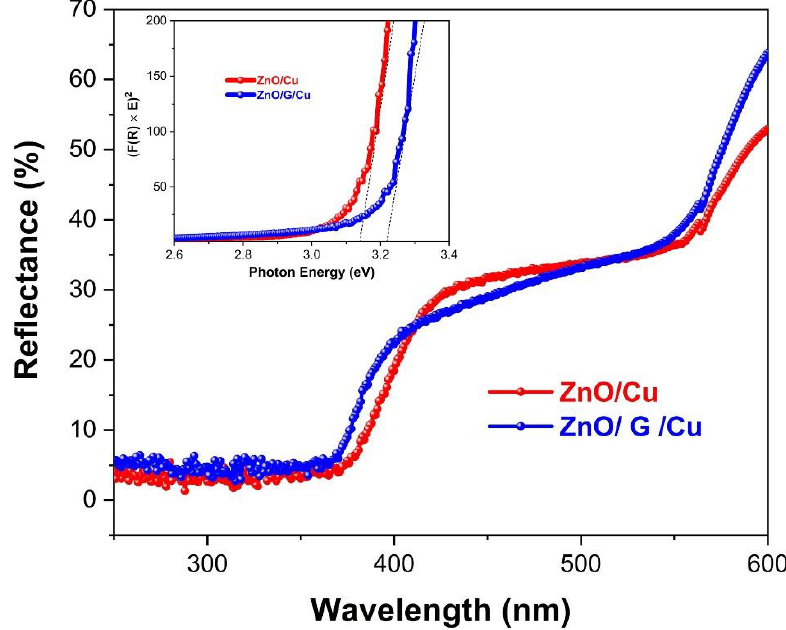
Figure 11. Modified Kubelka – Munk function for direct band gap energy (F(R) × E) 2 versus photon energy (Inset) and UV – Vis total reflectance spectra of ZnO/Cu and